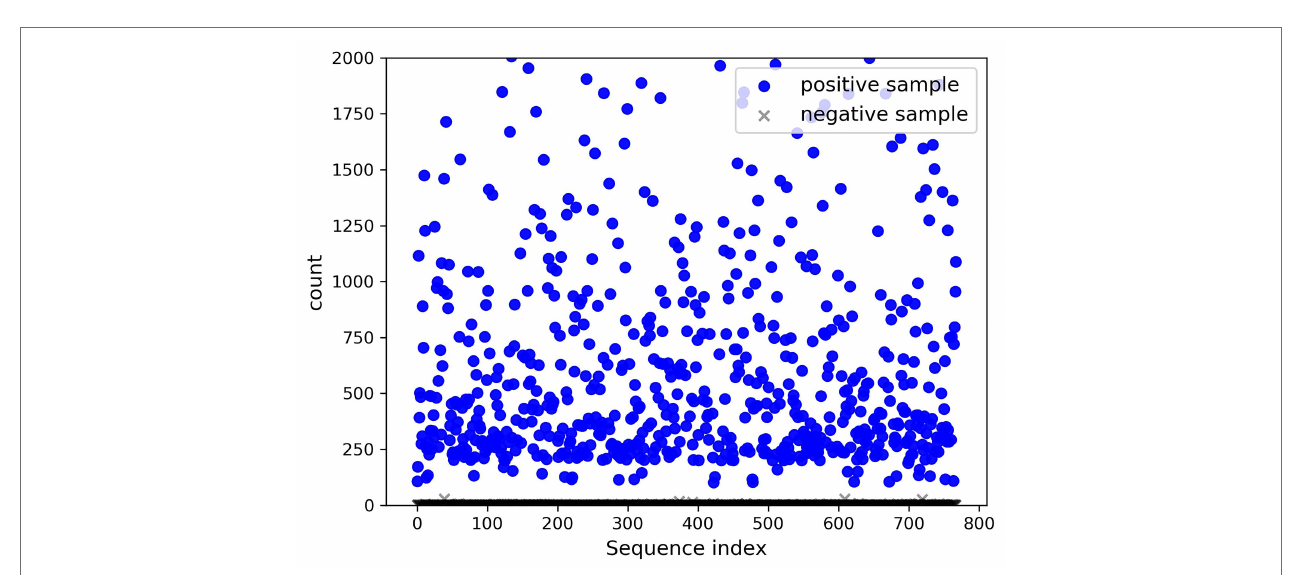
FIGURE 9 | Comparison chart of positive and negative sample expression (upper limit 2,000).